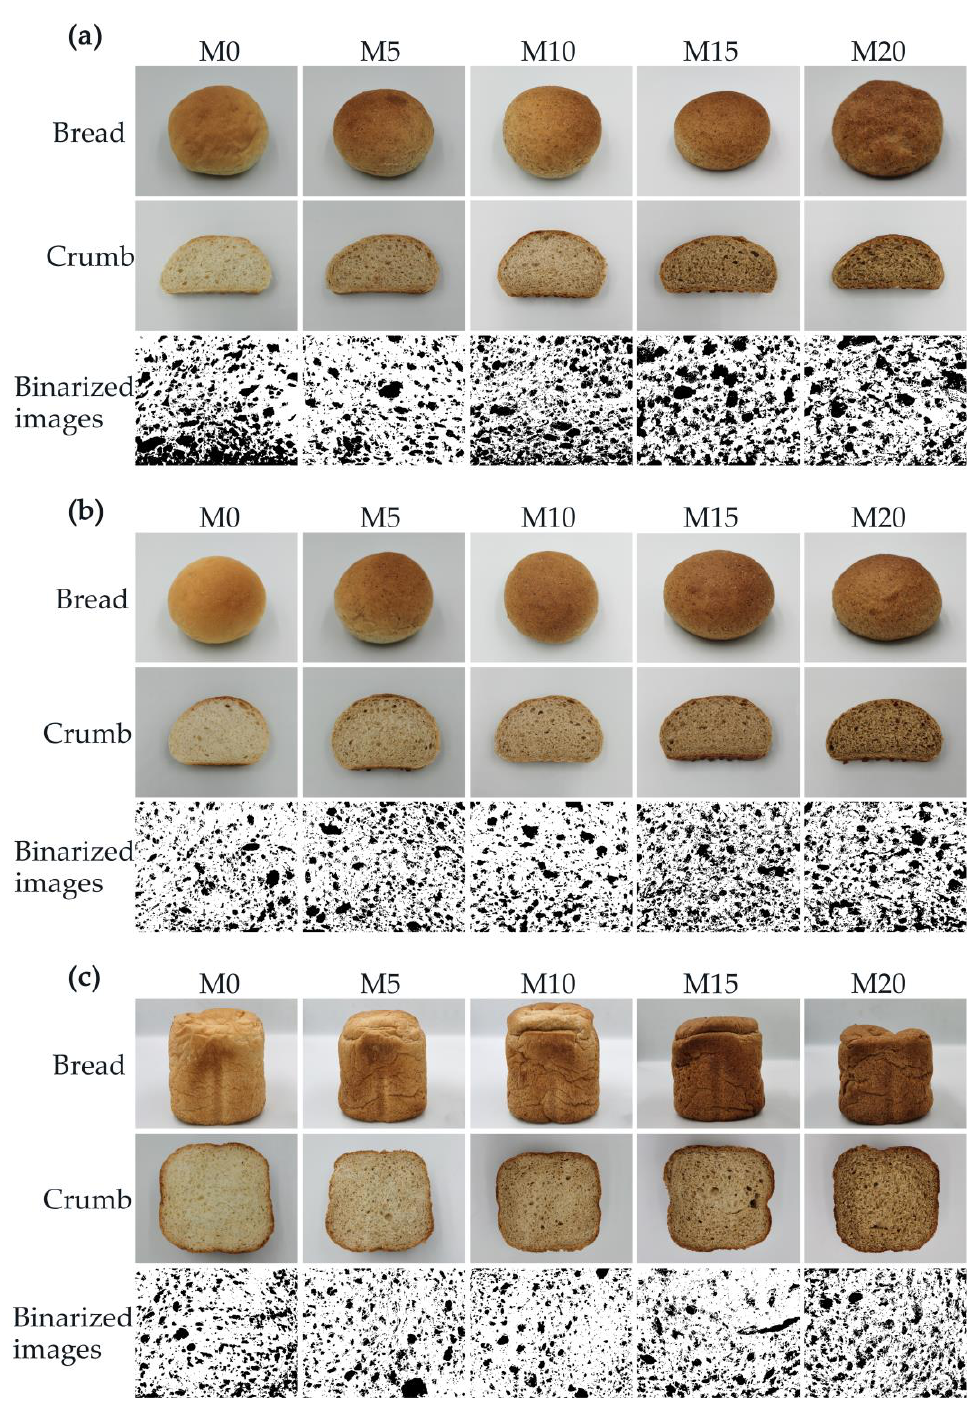
Figure 5. Visual appearance of the bread and crumb and the binarized images of the cross-sections with 0% (M0), 5% (M5), 10% (M10), 15% (M15), and 20% (M20) mealworm powder: ( a ) GB/T 35869-2018 Rapid-baking method; ( b ) GB/T 14611-2008 Straight dough method; ( c ) automatic bread maker method.